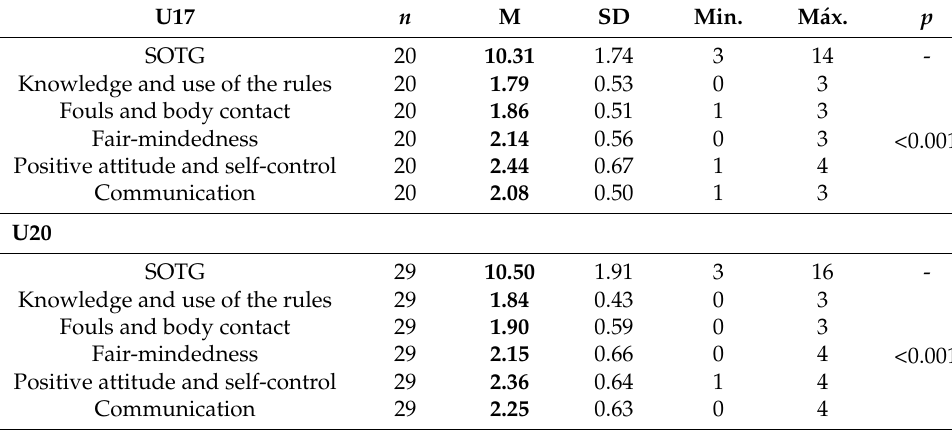
Table 1. Overall and detailed SOTG scores for U17 and U20 divisions. U17 n M SD